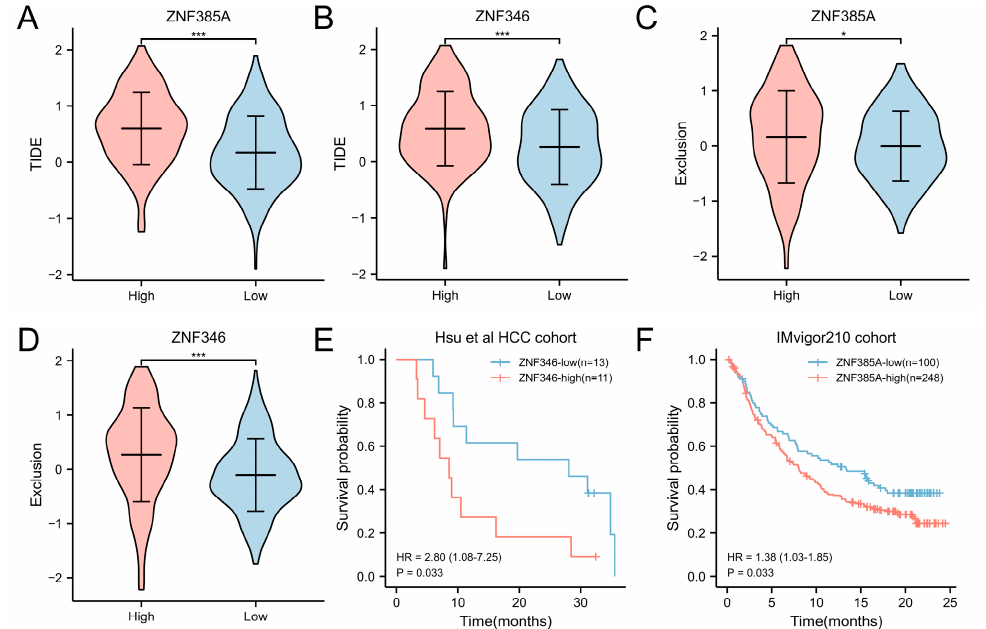
Figure 8. Overexpression of ZNF385A and ZNF346 predicts resistance to immunotherapy. ( A , B ) The TIDE score in ZNF385A ( A ) and ZNF346 ( B ) subgroups. ( C , D ) The T-cell exclusion score in ZNF385A ( C ) and ZNF346 ( D ) subgroups. ( E ) Survival curves of the ZNF346 subgroups in Hsu HCC cohort. ( F ) Survival curves of the ZNF385A subgroups in IMvigor210 cohort. * p < 0.05, *** p < 0.001.